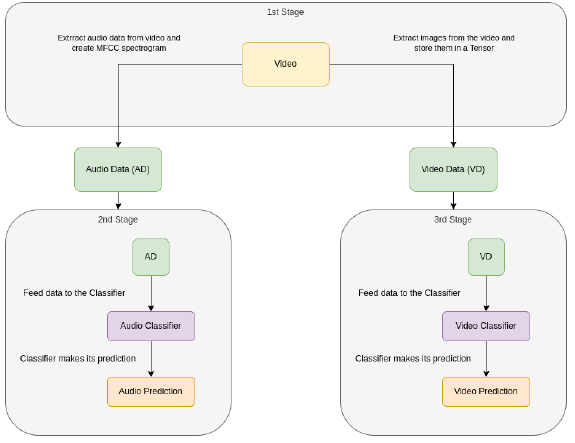
Figure 1. System pipeline